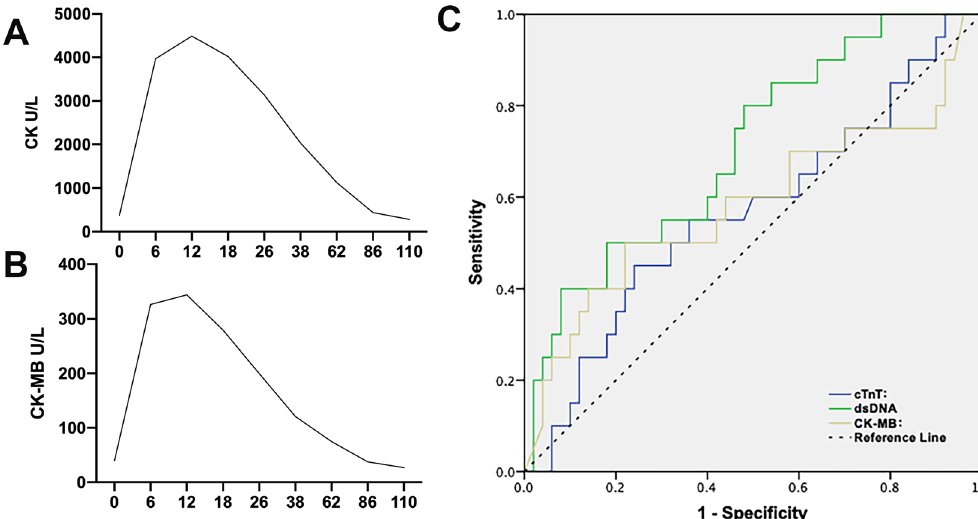
Figure 4. Time-concentration curves of cardiac biomarkers level and ROC curves analysis for prediction MACEs time-concentration curve of CK and ( B ) CK-MB: the curves for CK, CK-MB reached peak levels by 6 to 12 h, and decreased steadily thereafter. ( C ) The AUC of troponin T, CK-MB and dsDNA were 0.68, 0.57 and 0.72 respectively. AUC: area under curve; ROC: Receiver operating characteristic; MACEs: major adverse cardiac